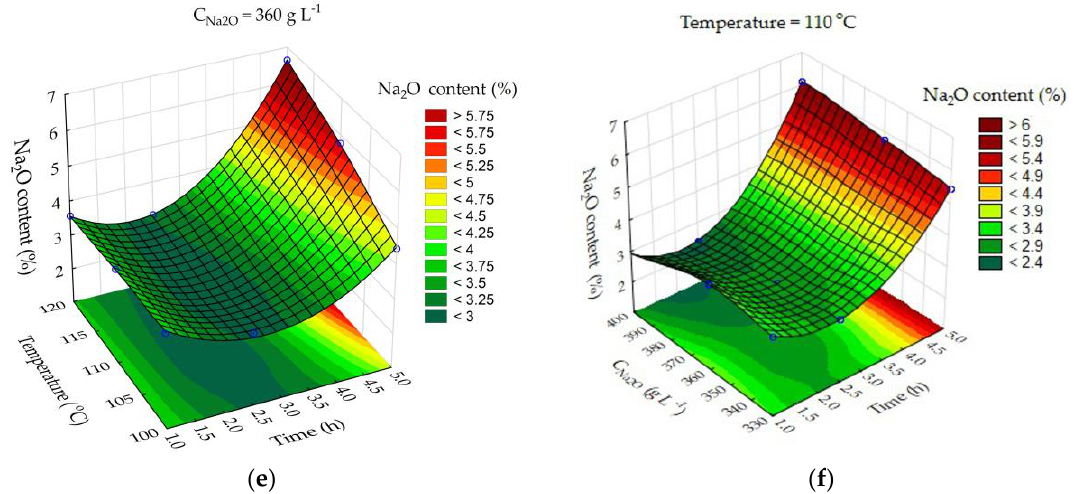
Figure 6. Neural network response surfaces for the effect of time and temperature on Al extraction from bauxite residue (BR) ( a ); effect of time and Na 2 O concentration on Al extraction from BR ( b ); effect of time and temperature on Fe content in the solid residue ( c ); effect of time and Na 2 O concentration on Fe content in the solid residue ( d ); effect of time and temperature on Na 2 O content in the solid residue ( e ); effect of time and Na 2 O concentration on Na 2 O content in the solid residue ( f ).